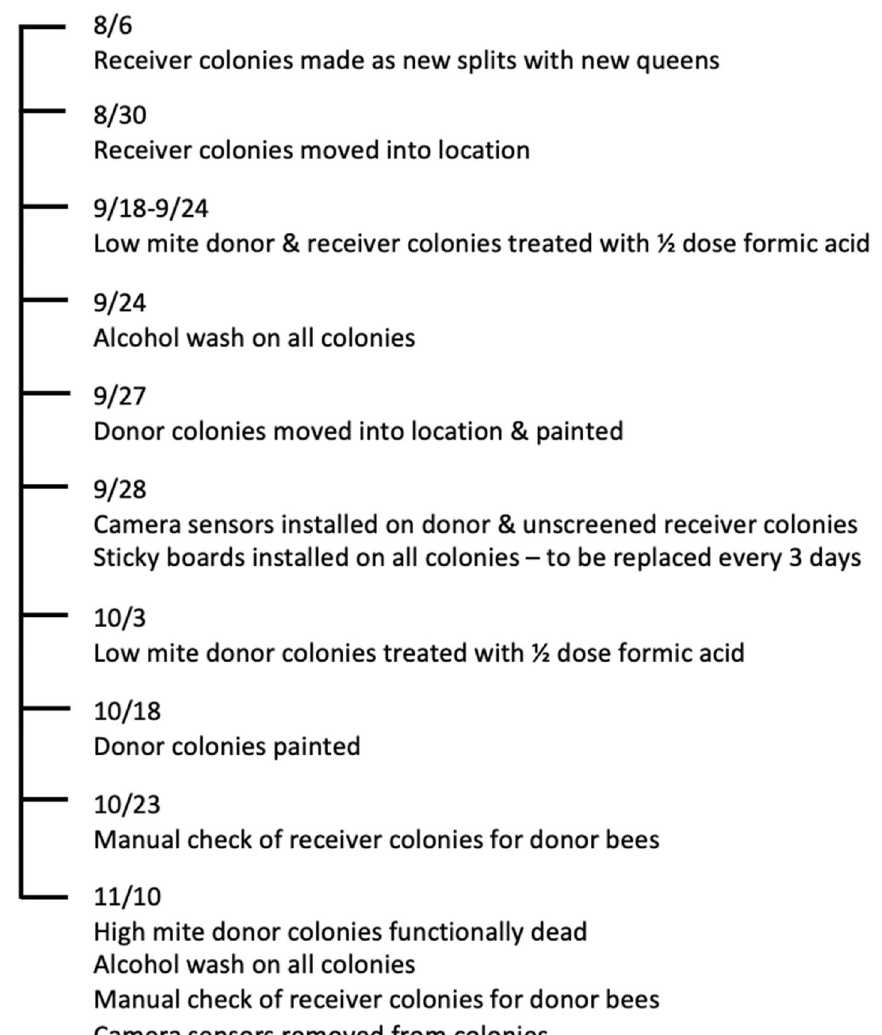
Figure 6. Timeline of study events including treatment, sampling, and colony